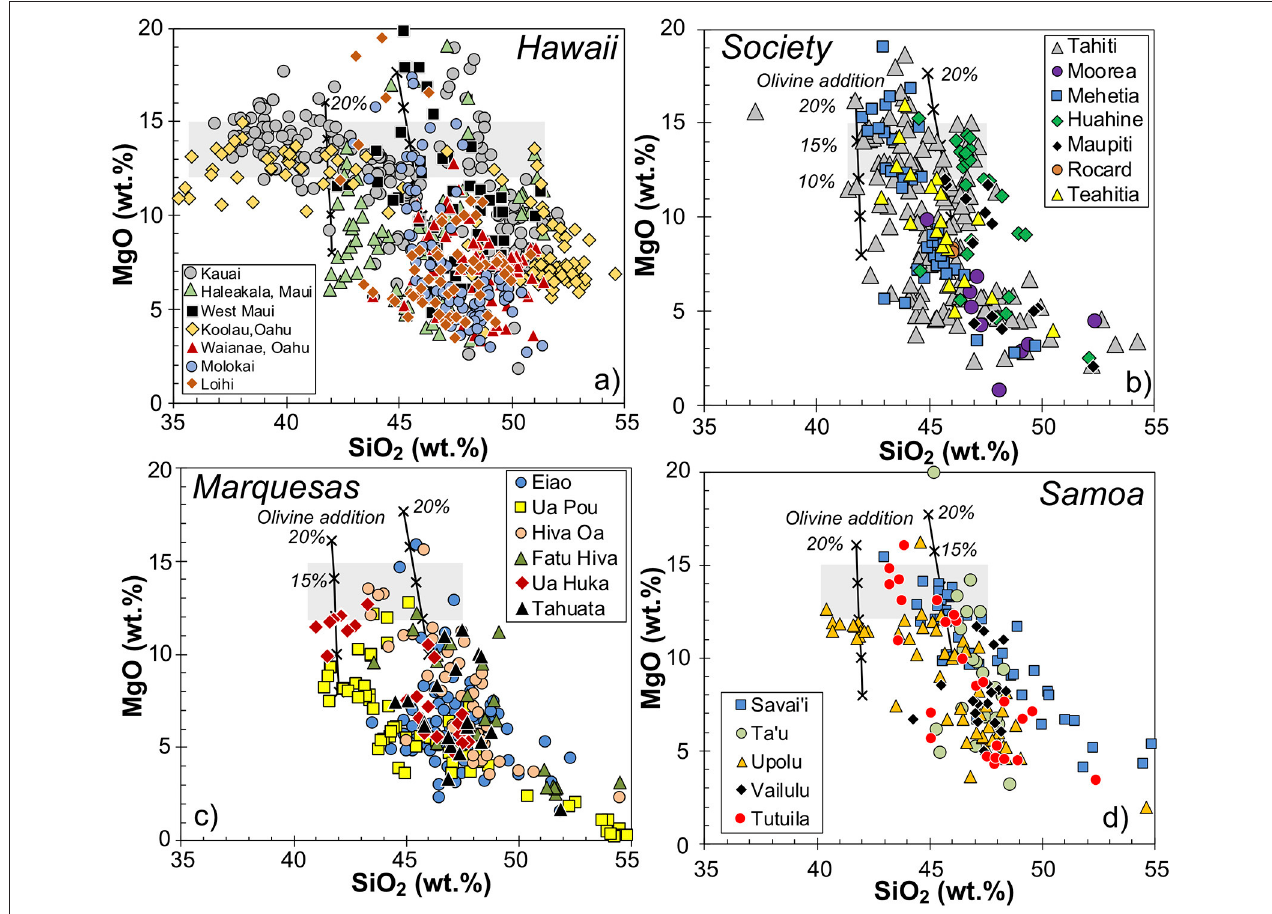
FIGURE 4 | The variation of SiO 2 vs. MgO contents in the lavas from the (a) Hawaiian, (b) Society, (c) Marquesas, and (d) Samoa hotspots. The SiO 2 contents typically increase with decreasing MgO due to crystal fractionation processes. Lavas with 12–15 wt.% MgO represent near-primary compositions of magmas from the mantle and their range is indicated by the gray box. Note that the Hawaiian volcanoes show a much larger range of SiO 2 contents (36–52 wt.%) for these primary magmas than the other hotspots (41–48 wt.%). The two black lines show the addition of olivine with forsterite (Fo) contents of 88 in 5% increments indicated by the crosses. Data sources can be found in the Supplementary Material